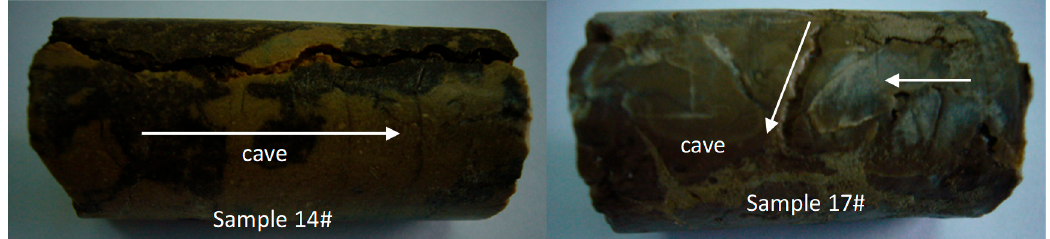
Figure 12. Morphology of two samples after acid fluid processing.